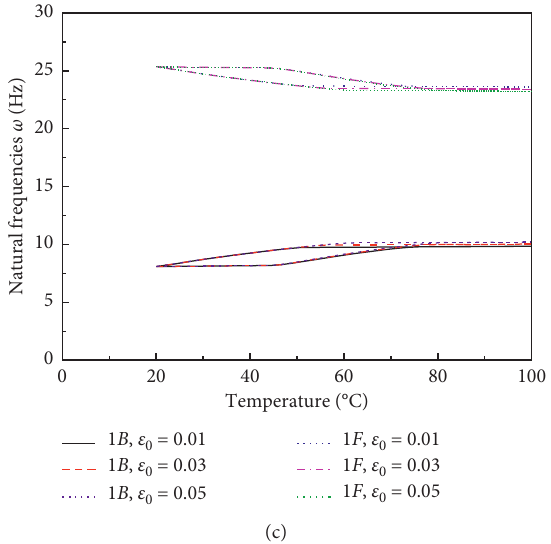
Figure 8: The first natural frequencies versus temperature of the tapered composite rotating shaft for different SMA fiber initial strain ( σ � 0 . 5 , Ω � 1000rpm , θ � 30 ° , Vs � 0 . 1): (a) C-C; (b) S-S; (c)